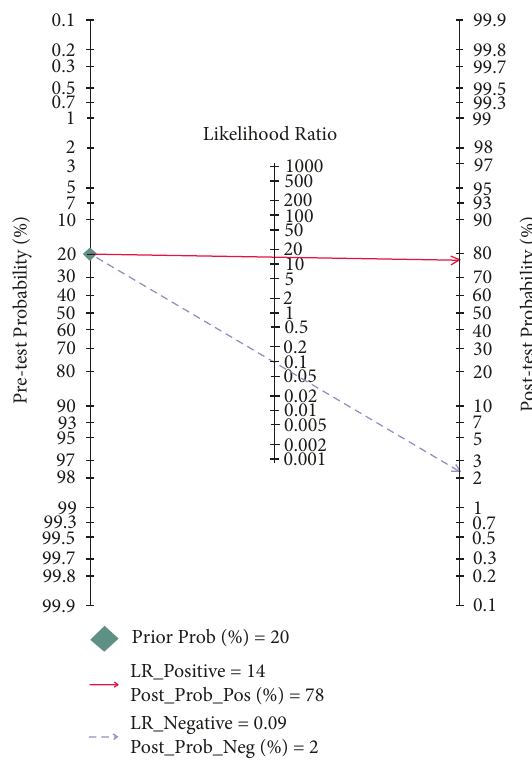
Figure 5: Fagan’s